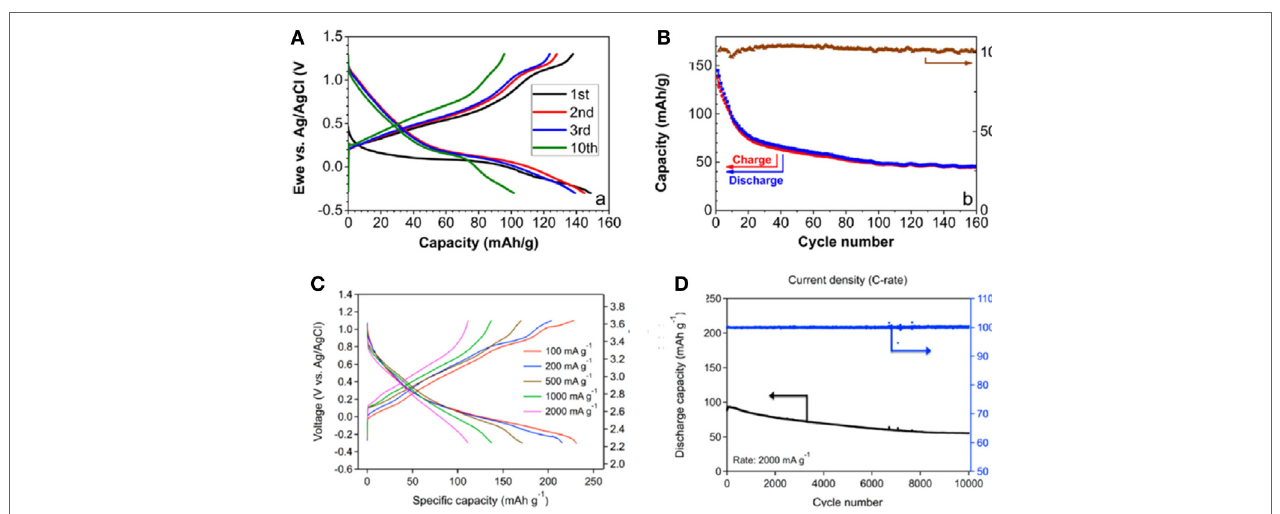
FigURe 4 | Performance of Birnessite-MnO 2 in aqueous magnesium battery. (A) Birnessite-Mg 0.15 MnO 2 ⋅ 0.9H 2 O in 0.5 M Mg(ClO 4 ) 2 and (B) capacity and Coulombic efficiency evolution at 2 C. Reprinted with permission from Sun et al. (2016). Copyright 2016 American Chemical Society. (C) Birnessite-MnO 2 ⋅ 0.94H 2 O in 0.5